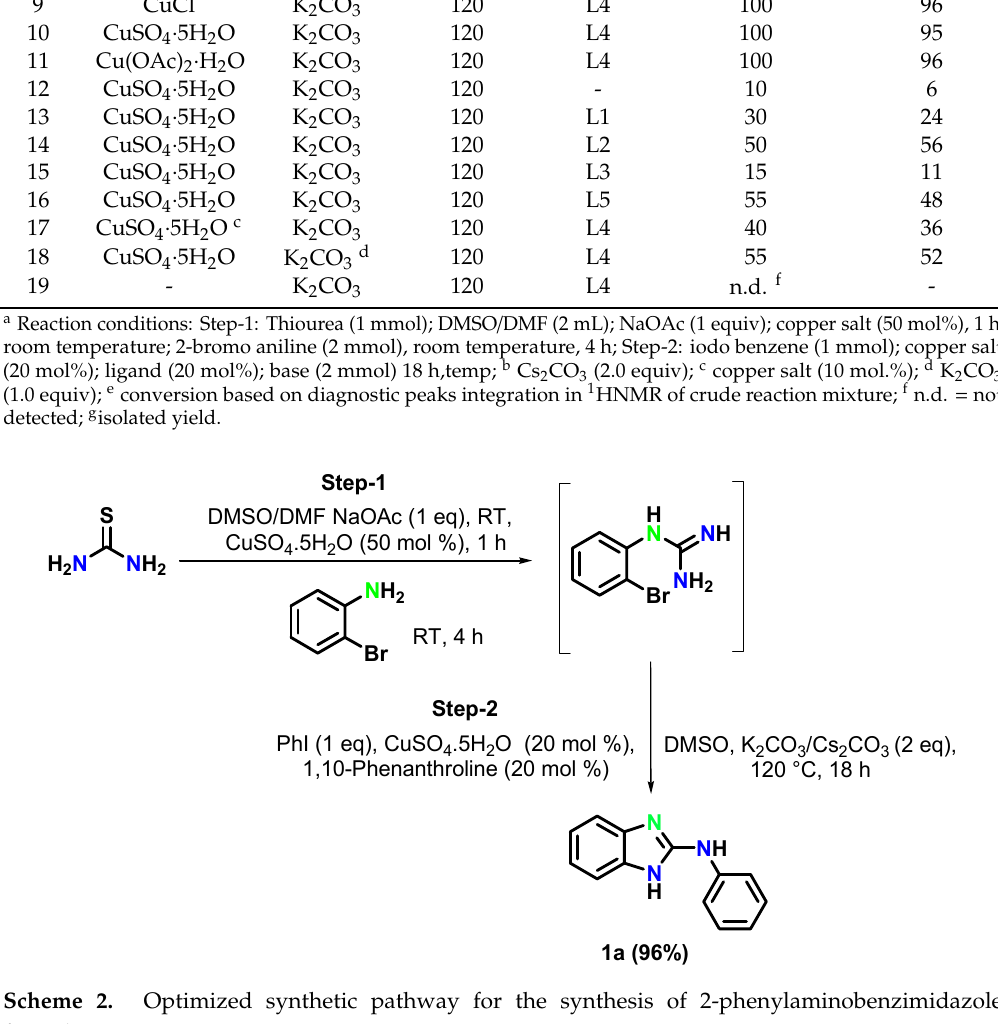
Table 1. Optimization of the reaction for the synthesis of 2-aminophenyl benzoimidazole a . - K 2 CO 3 120 L4 n.d. f - Entry Copper Salt Base Temp ◦ C Ligand Conversion e 1a Yield (%) g a Reaction conditions: Step-1: Thiourea (1 mmol); DMSO/DMF (2 mL); NaOAc (1 equiv); copper salt 1 CuI K 2 CO 3 RT L4 n.d. f - (50 mol%), 1 h, room temperature; 2-bromo aniline (2 mmol), room temperature, 4 h; Step-2: iodo 2 CuI K 2 CO 3 50 L4 n.d. f - benzene (1 mmol); copper salt (20 mol%); ligand (20 mol%); base (2 mmol) 18 h,temp; b Cs 2 CO 3 (2.0 3 CuI K 2 CO 3 equiv); c copper salt (10 mol.%); d K 2 CO 3 (1.0 equiv); e conversion based on diagnostic peaks integration in 1 HNMR of crude reaction mixture; f n.d. = not detected; g isolated yield. CuI 6 CuI KOH 120 66 7